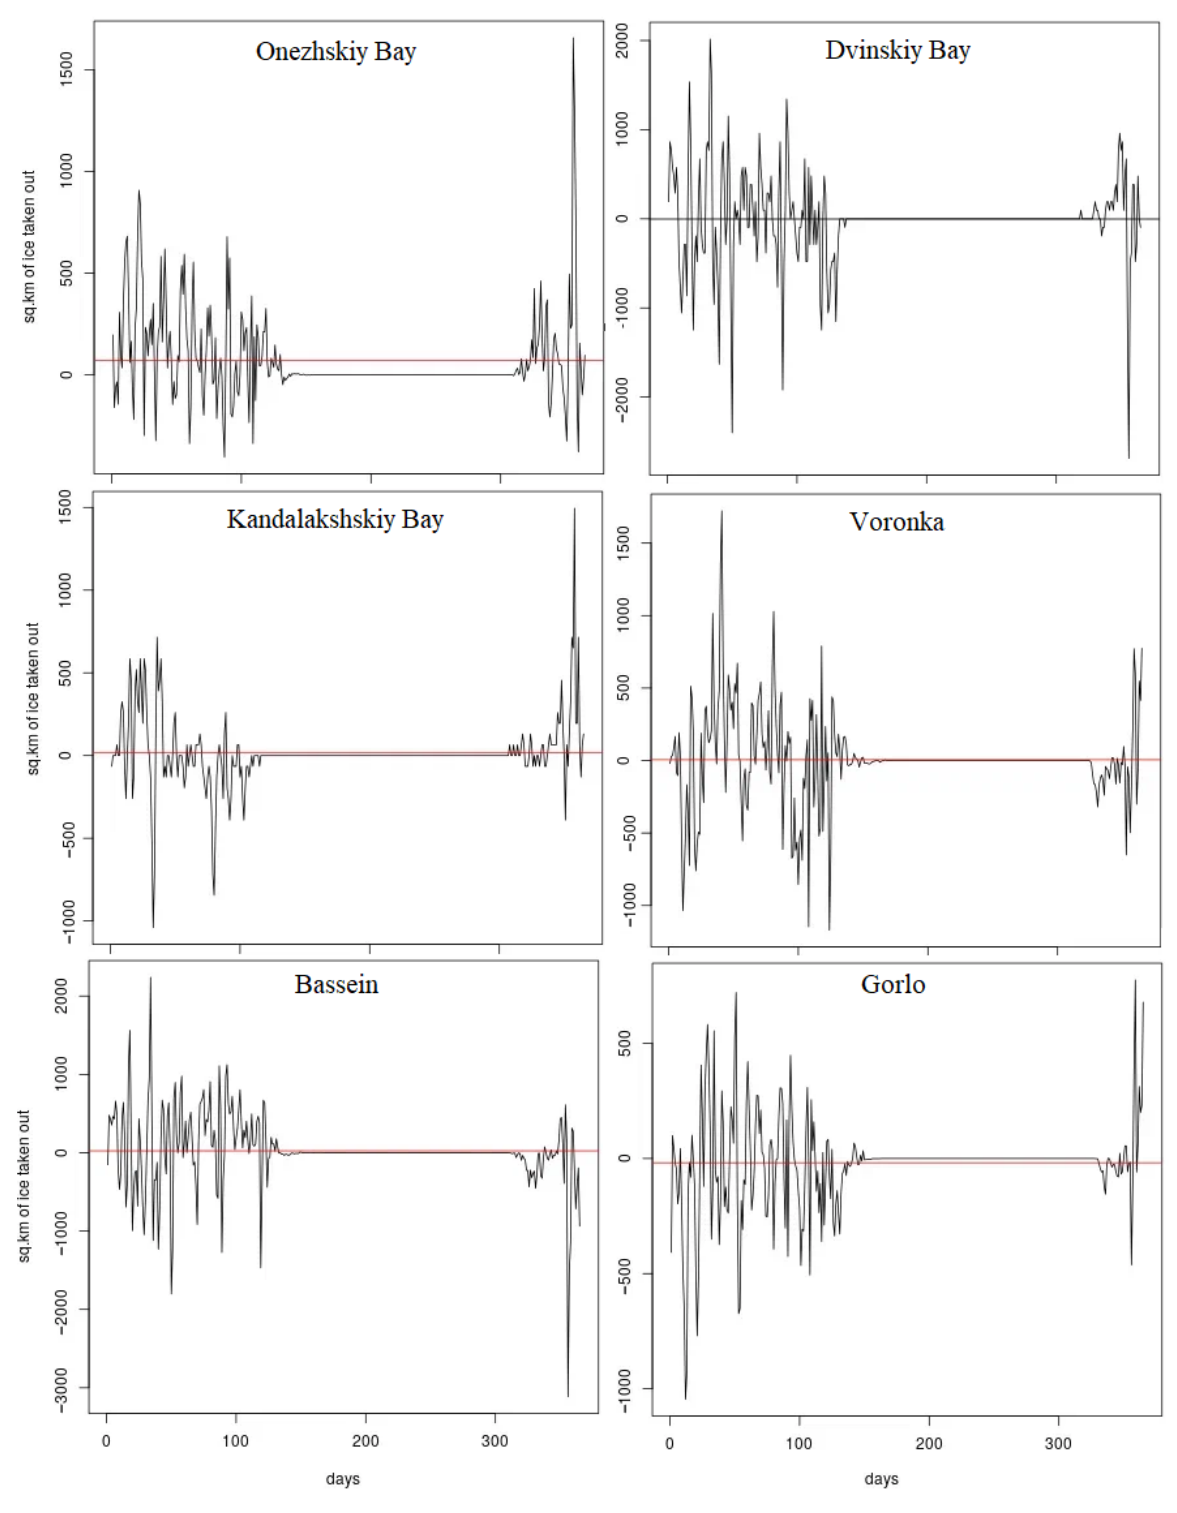
Figure 2. The ice carried out of (positive values) and into (negative values) the sea region during a year, km 2 ; the red line is the time